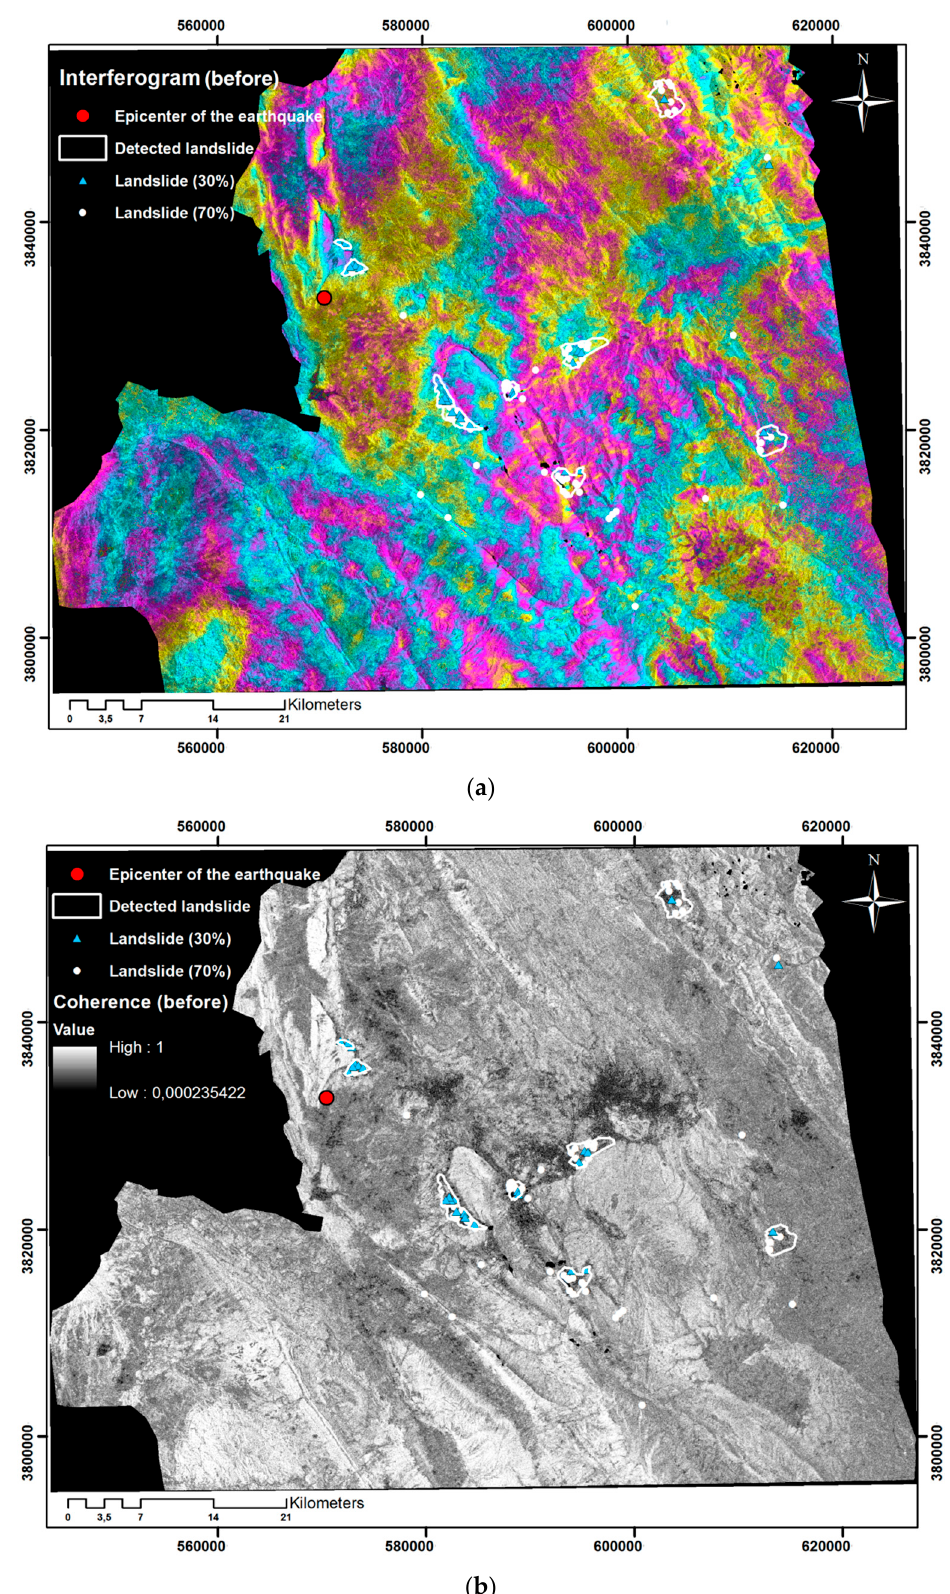
Figure 10. The interferogram ( a ) and coherence ( b ) before the earthquake.